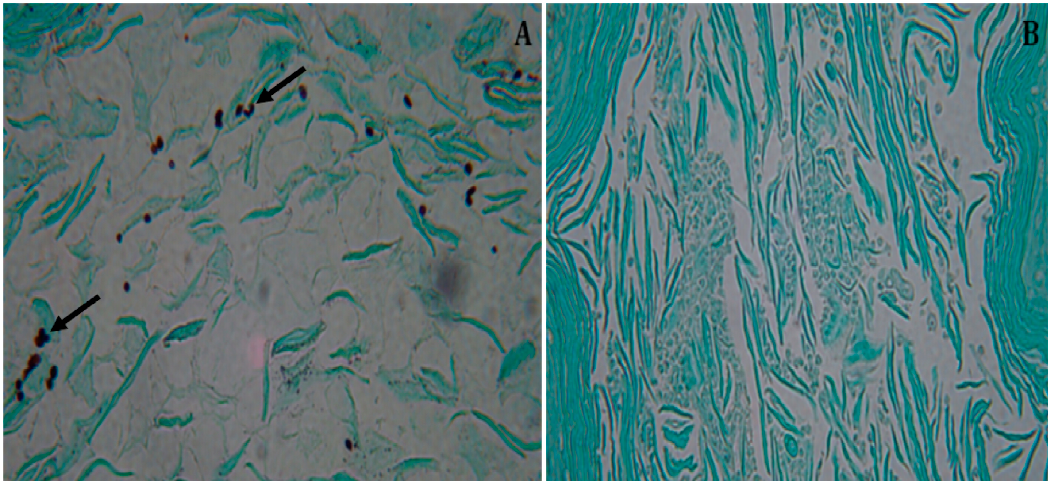
Figure 5. Histopathology of the vaginal canal of BALB/c mice. Histopathology of six BALB/c mice whose vaginal canal was infected with 3 × 10 5 yeasts of C. albicans ATCC 90028 . Animals were treated every 24 h, for 7 days, after infection. Treatment was carried out via i.v. (intravaginal) administration, with 10% (308.28 µM) limonene cream. Female mice were sacrificed 8 days after infection. Three vaginal sections per animal were collected and stained with Gomori-Grocott. ( A ) Control group, infected and treated with neutral cream only (arrows indicate the presence of C. albicans yeasts on the vaginal canal tissue). ( B ) Vaginal canal of mice treated with 10% (308.28 µ M) limonene cream without C. albicans yeasts. Original magnification, 40 ×